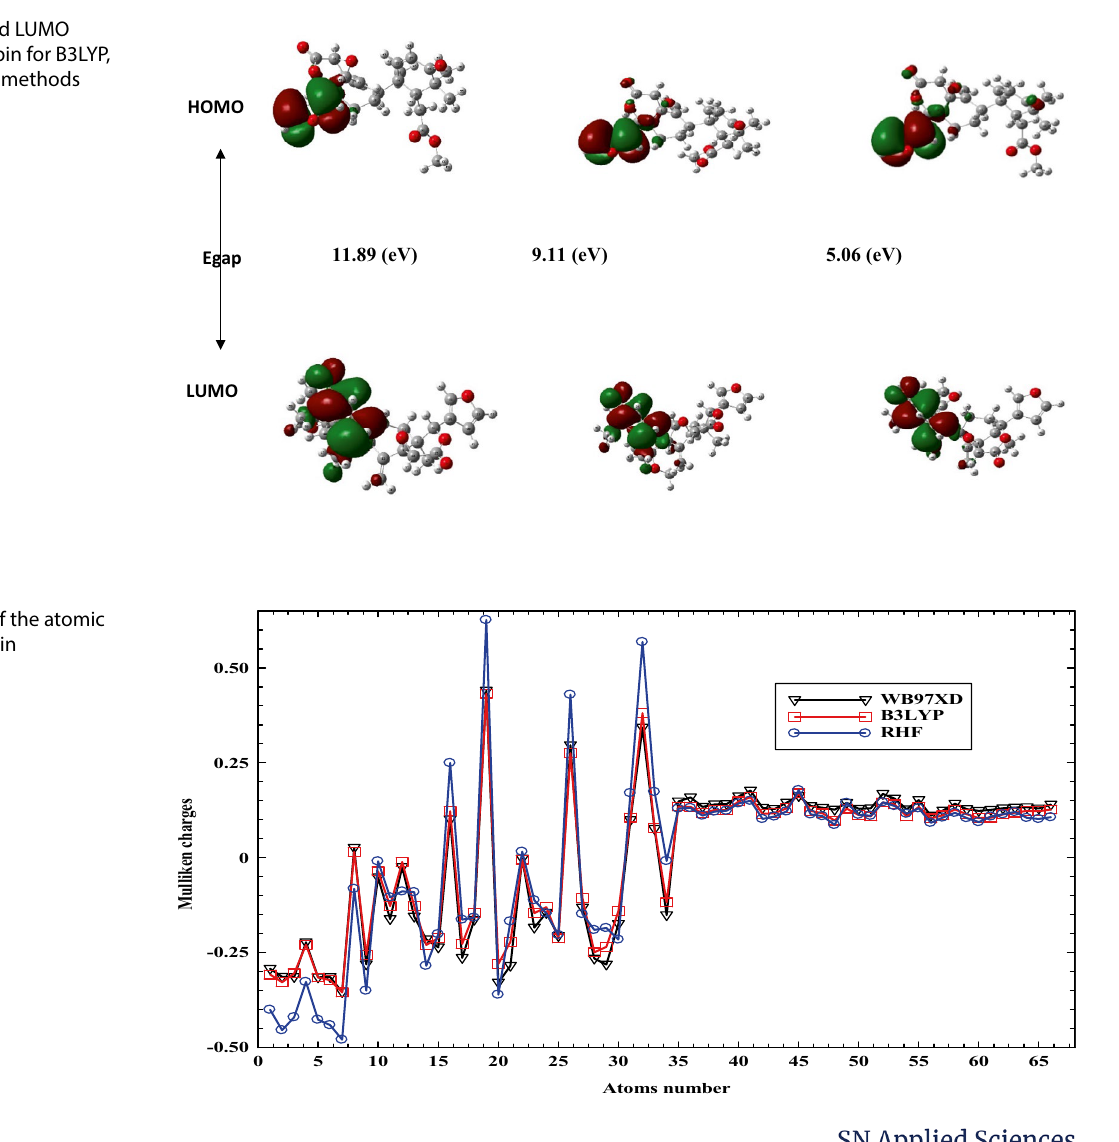
Fig. 10 HOMO and LUMO orbitals of andirobin for B3LYP,